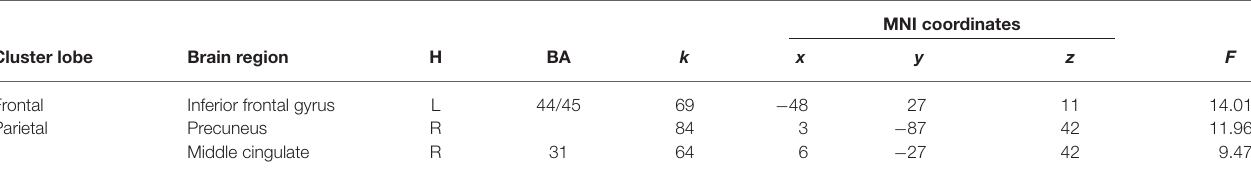
MNI coordinates